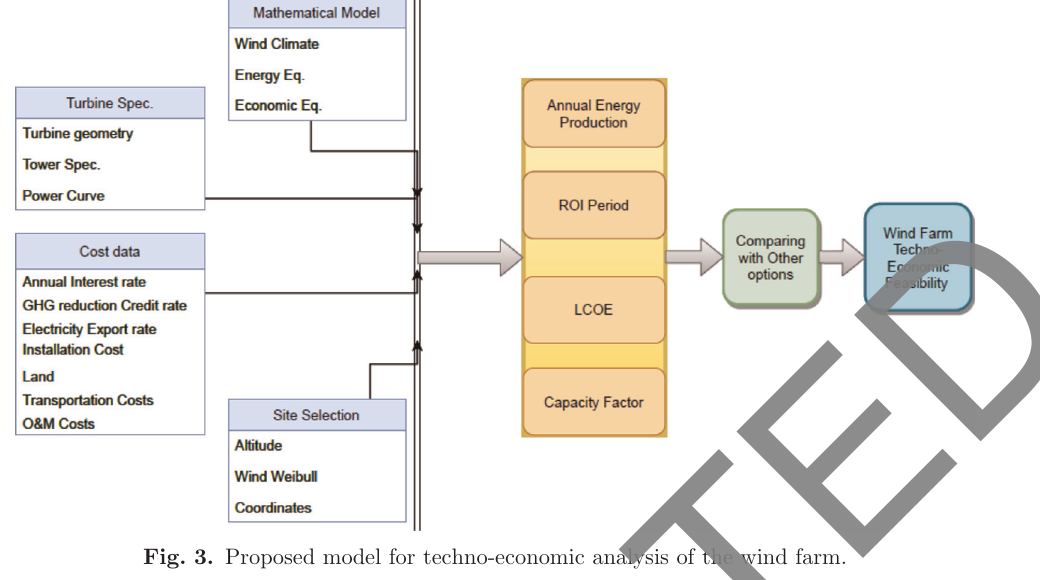
Fig. 3. Proposed model for techno-economic analysis of the wind farm.